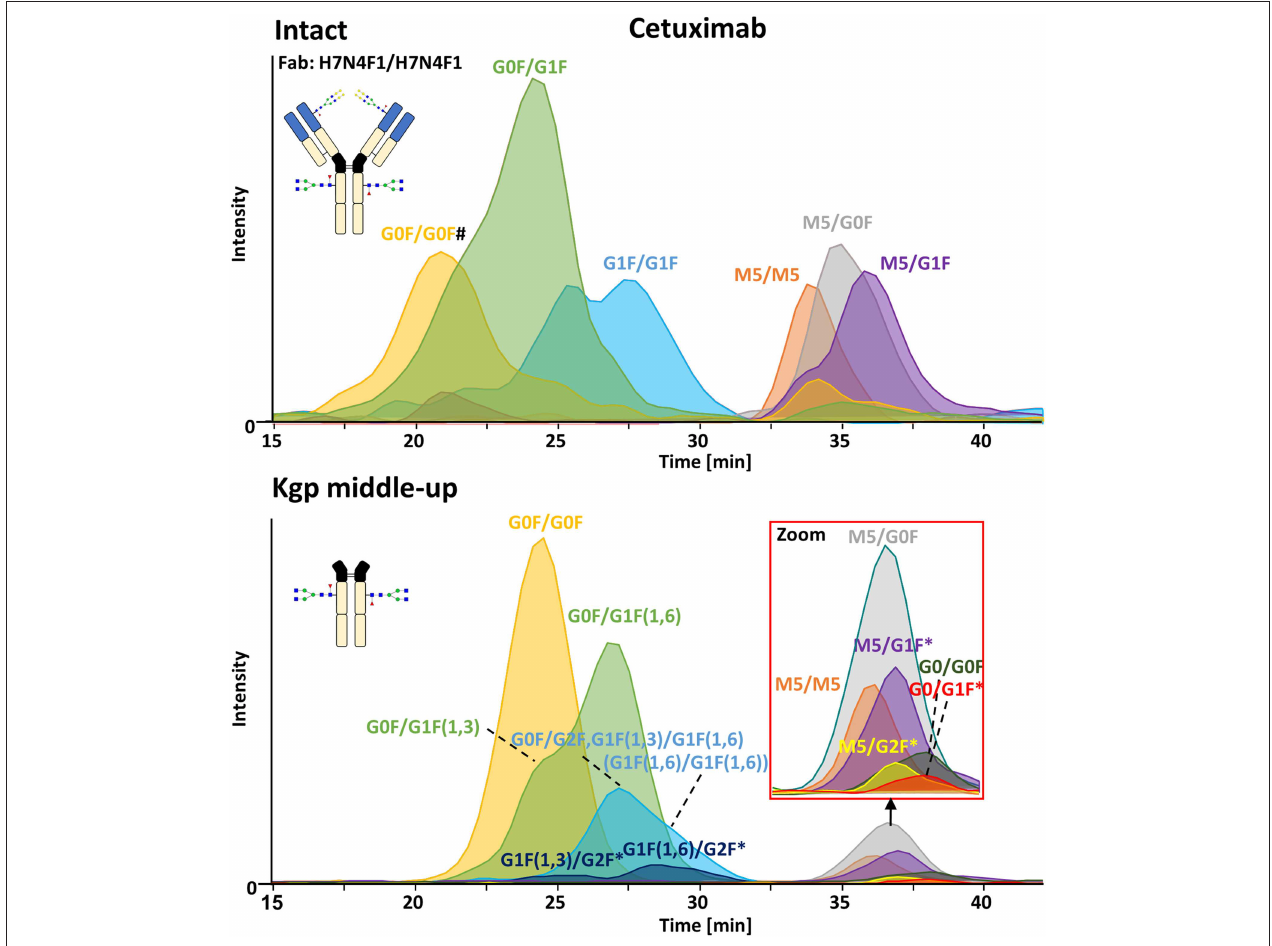
FIGURE 4 | Fc È RIIIa AC-MS of cetuximab on intact and Kgp middle-up level. Intact analysis was restricted to the main Fab glycoform (H7N4F1/H7N4F1) and the most abundant Fc glycoforms (G0F, G1F, M5). G0F/G0F# is marked exemplarily for isomeric EICs: G0F/G1F exhibits the same EIC if the Fab glycoform is H7N4F1/H6N4F1. For middle-up Fc È RIIIa AC-MS analysis, EICs of all detected Fc glycoforms are presented. Data for C-terminal lysine variants ( + K) are omitted for clarity. *indicates additional isomers listed in Supplementary Table 4